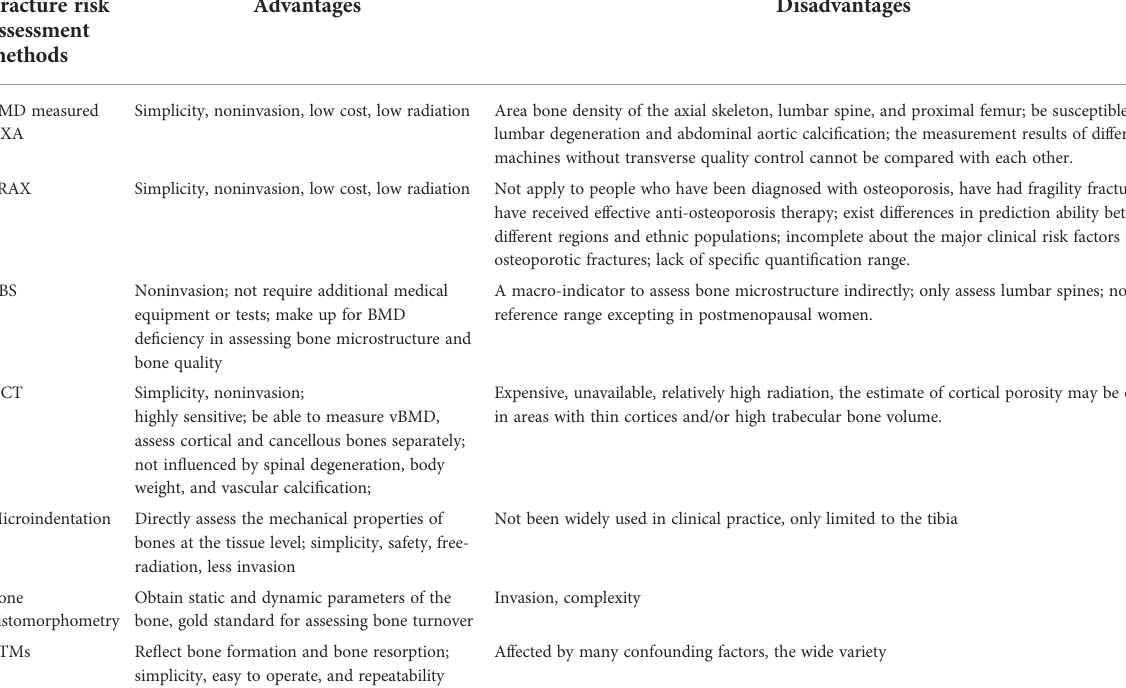
TABLE 2 Summary of fracture risk assessment methods and their respective advantages and